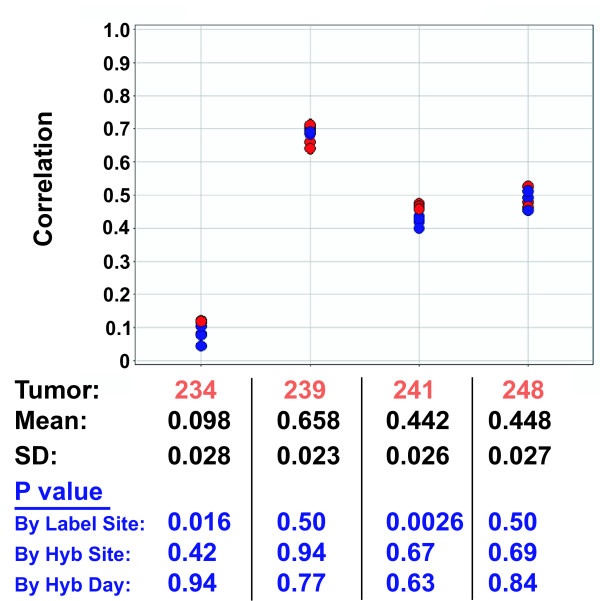
70 gene signature correlation values. The 70-gene signature correlation values for the four tumors were determined for each hybridization; these values indicate the correlation of the log ratios of the 70 signature genes from the tumor sample with the average log ratios from a previously defined set of patients [14]. The correlation values for each dye-swapped pair (y-axis) are plotted for each of the four tumors (x-axis). Red data points were labeled in Amsterdam, while blue data points were labeled in California. The mean and standard deviations of the correlation values for each tumor are indicated beneath the plot. Each set of hybridizations for each tumor was divided into two groups, based either on hybridization site, labeling site, or hybridization day. An ANOVA was then performed on the 70 gene signature correlation values obtained in the hybs for both groups, and the resulting P values for each tumor are shown.